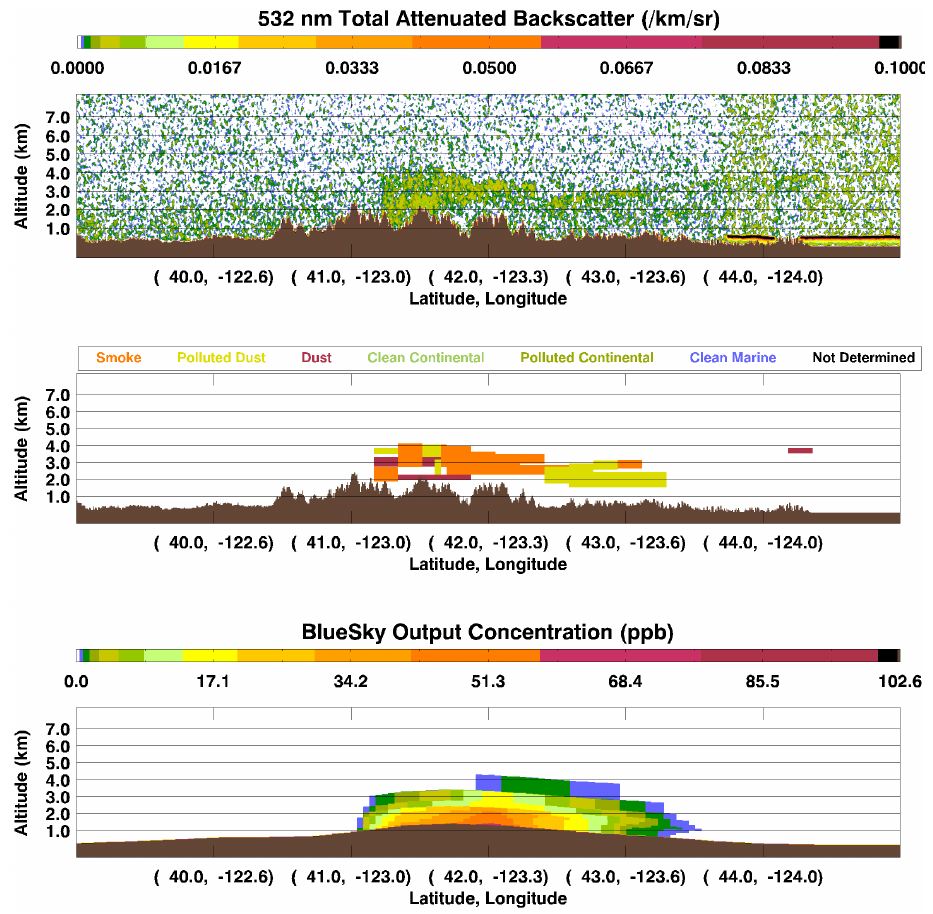
Figure 3. Example of matched profiles for CALIOP 532 nm total attenuated backscatter data (top), CALIOP aerosol layers (middle), and PM BlueSky—CMAQ modeling system (bottom) for 28 August